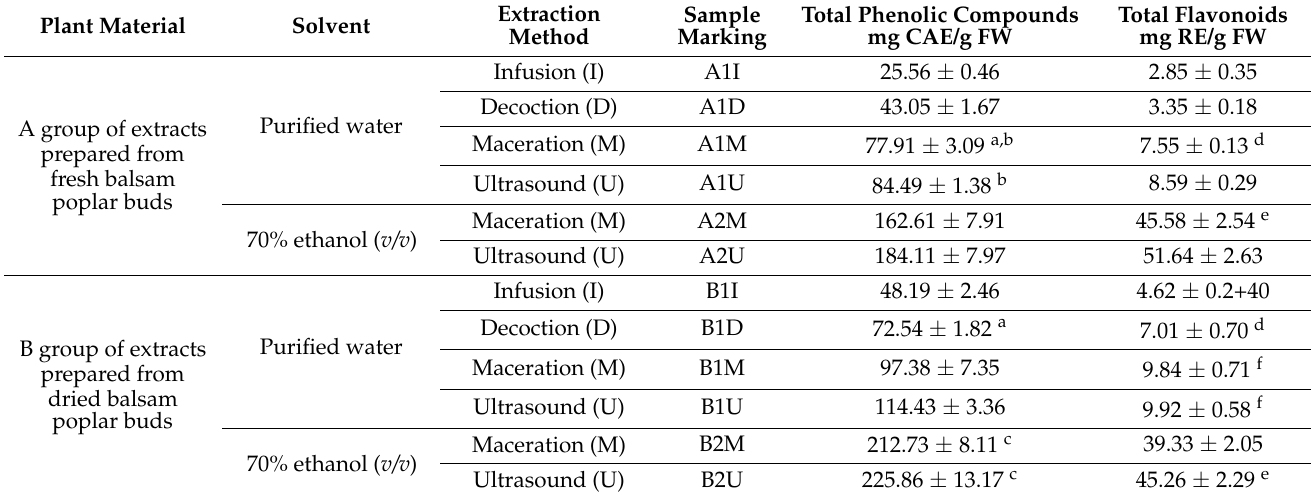
Pairwise comparisons using a Student’s t -test were performed for each extraction method, comparing pairs for phenol and flavonoid samples separately. The shared letters in superscript indicate that there was no statistically significant difference between the concentrations ( p >